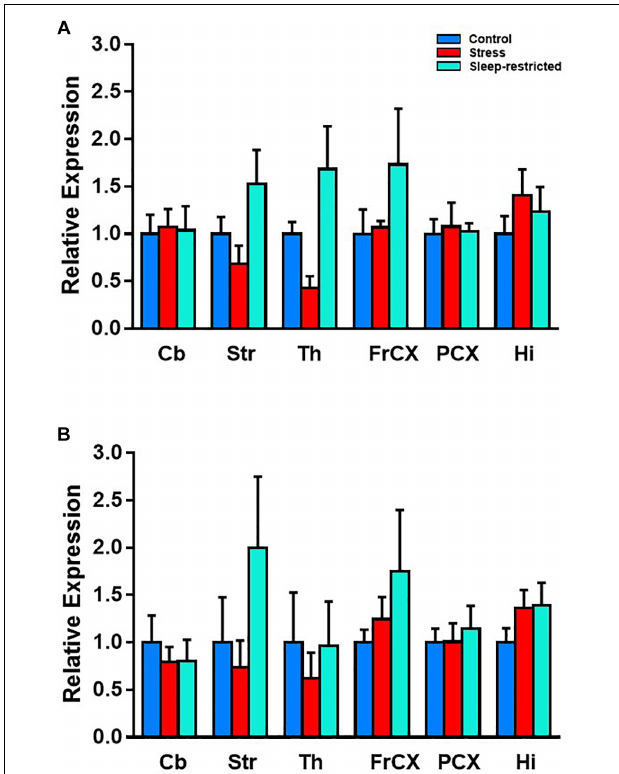
FIGURE 10 | Effects on p-S6 protein expression in six brain regions at P94. We analyzed p-S6 235/236 (A) and p-S6 240/244 (B) in multiple brain regions. Protein levels were normalized to control values. Results of ANOVA are presented in Table 4 . We found a statistically significant main effect of condition p = 0.038. This shows that, regardless of region or of phosphorylation site, p-S6 is increased following sleep restriction. Each bar represents mean ± SEM for control group ( n = 5), stress group ( n = 4), and sleep-restricted group ( n = 5). Cb, cerebellum; Str, striatum; Th, thalamus; FrCX, frontal cortex; PCX, parietal cortex; and Hi,